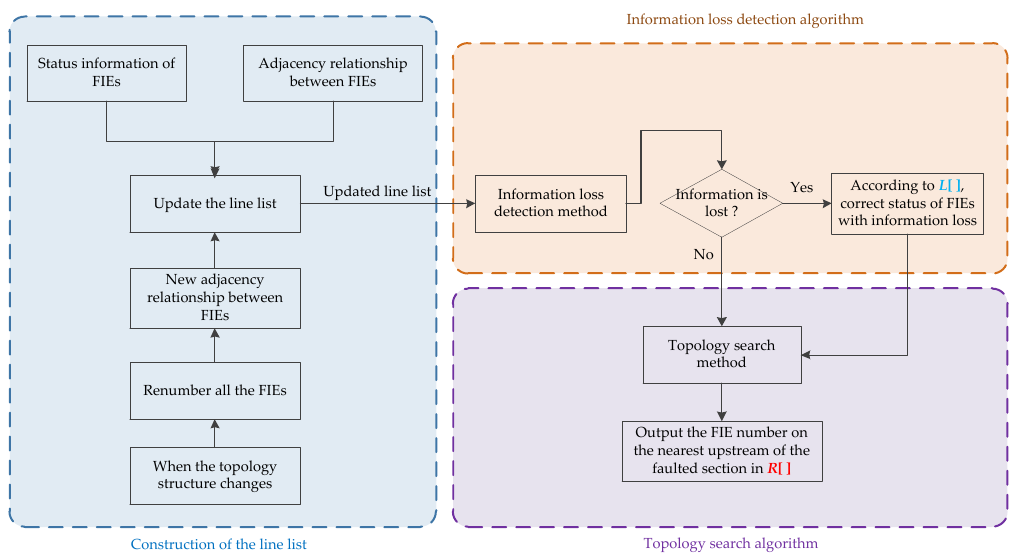
Figure 2. Flow chart of fault location method.